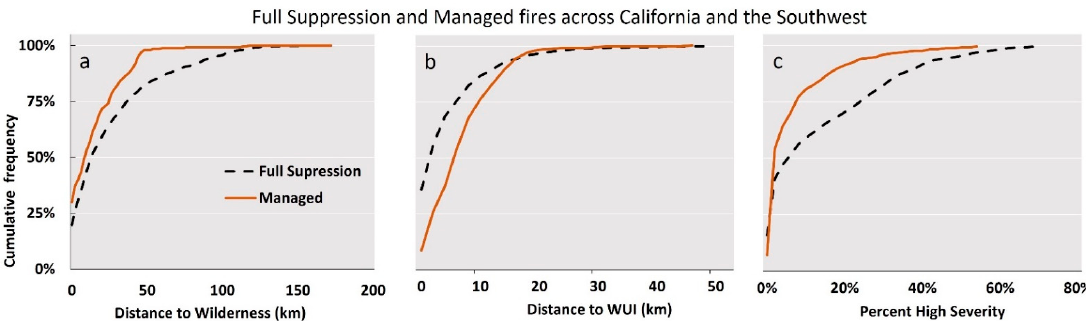
Figure 1. Comparison of full suppression ( n = 1180) and managed wildfires ( n = 254) based on ( a ) distance to wilderness, ( b ) distance to WUI, and ( c ) the percentage of high-severity burn area within the entire study area, which included the Southwest (Arizona and New Mexico) and California. Managed fires were closer to the wilderness, further from WUI, and had a smaller percentage of high-severity burn area.